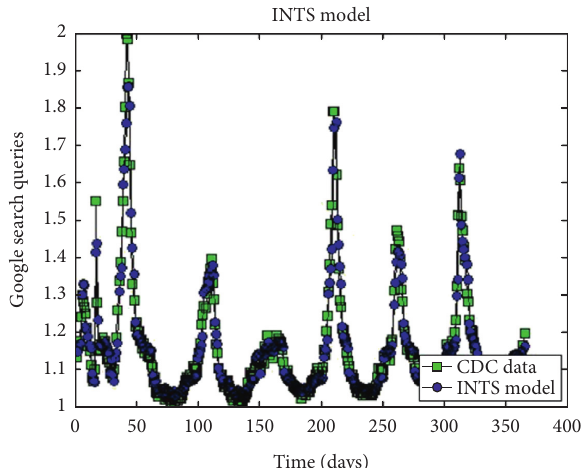
Figure 6: Performance of the INTS model.